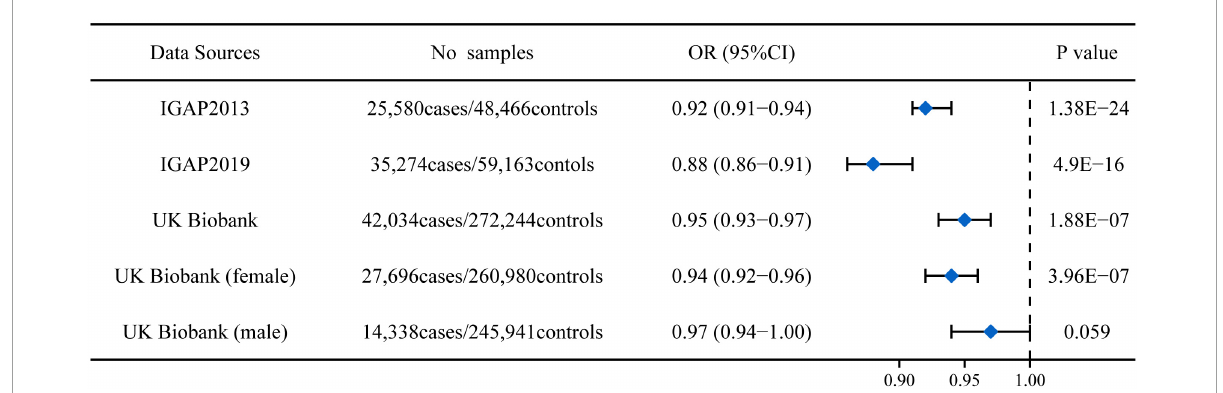
FIGURE1 Association between rs11136000 variant T allele and AD. IGAP, International Genomics of Alzheimer’s Project. The statistically significant association is defined to be P <